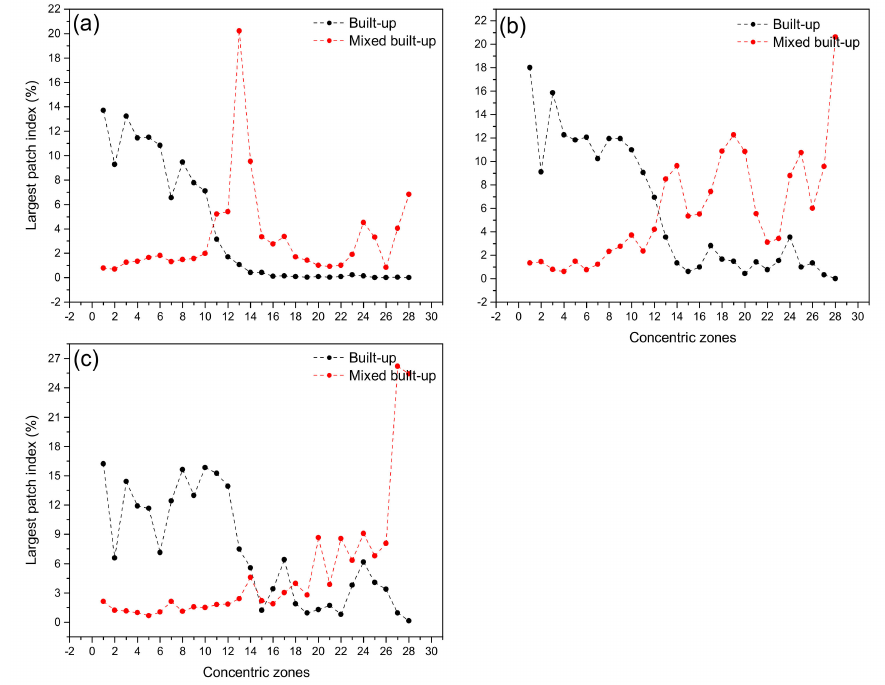
Figure 18. Pattern of LPI plotted against the sequential concentric zones of 1 km each around the river Hooghly within the KMA; the pattern of LPI of built-up and mixed built-up for the concentric zones in ( a ) 1996, ( b ) 2006, and ( c )